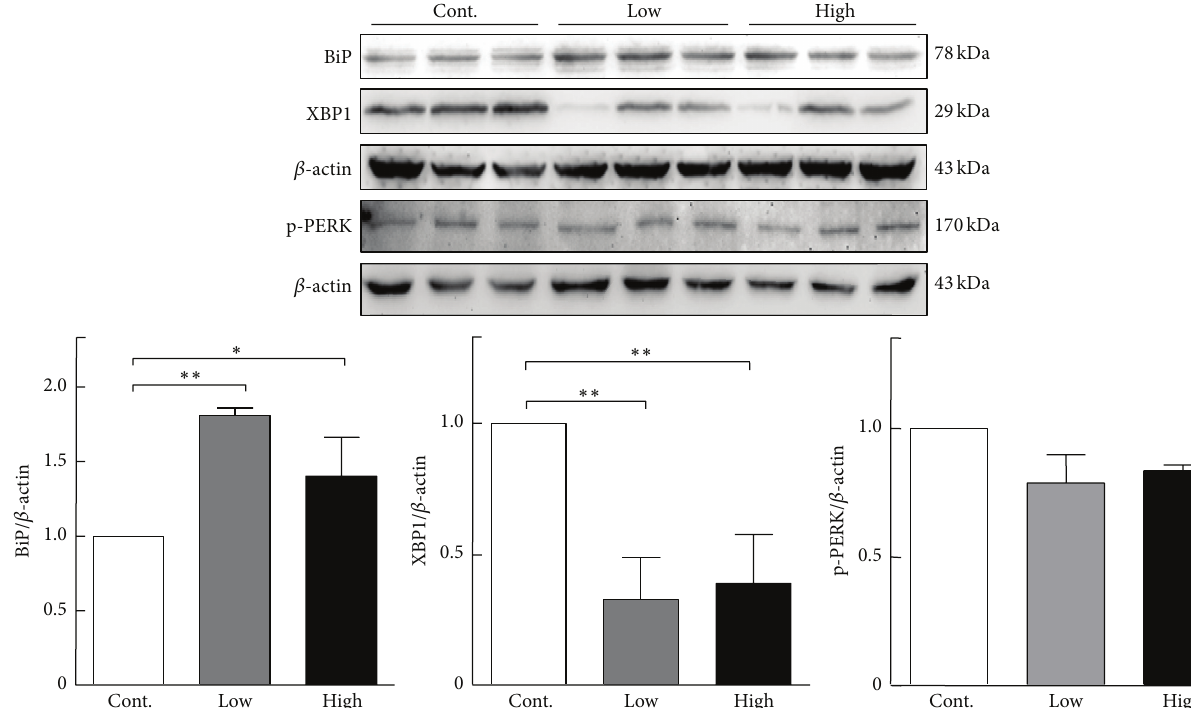
Figure 5: Western blotting analysis of x-box-binding protein 1 (XBP1), binding immunoglobulin protein (BiP), and phosphorylated eukaryotic translation initiation factor 2-kinase 3 (p-PERK) protein expressions in the liver. Data are expressed as the mean ± SEM. 𝑛 = 3 for each group (pooled samples). ∗ 𝑃 < 0.05 , ∗∗ 𝑃 < 0.01 versus control.